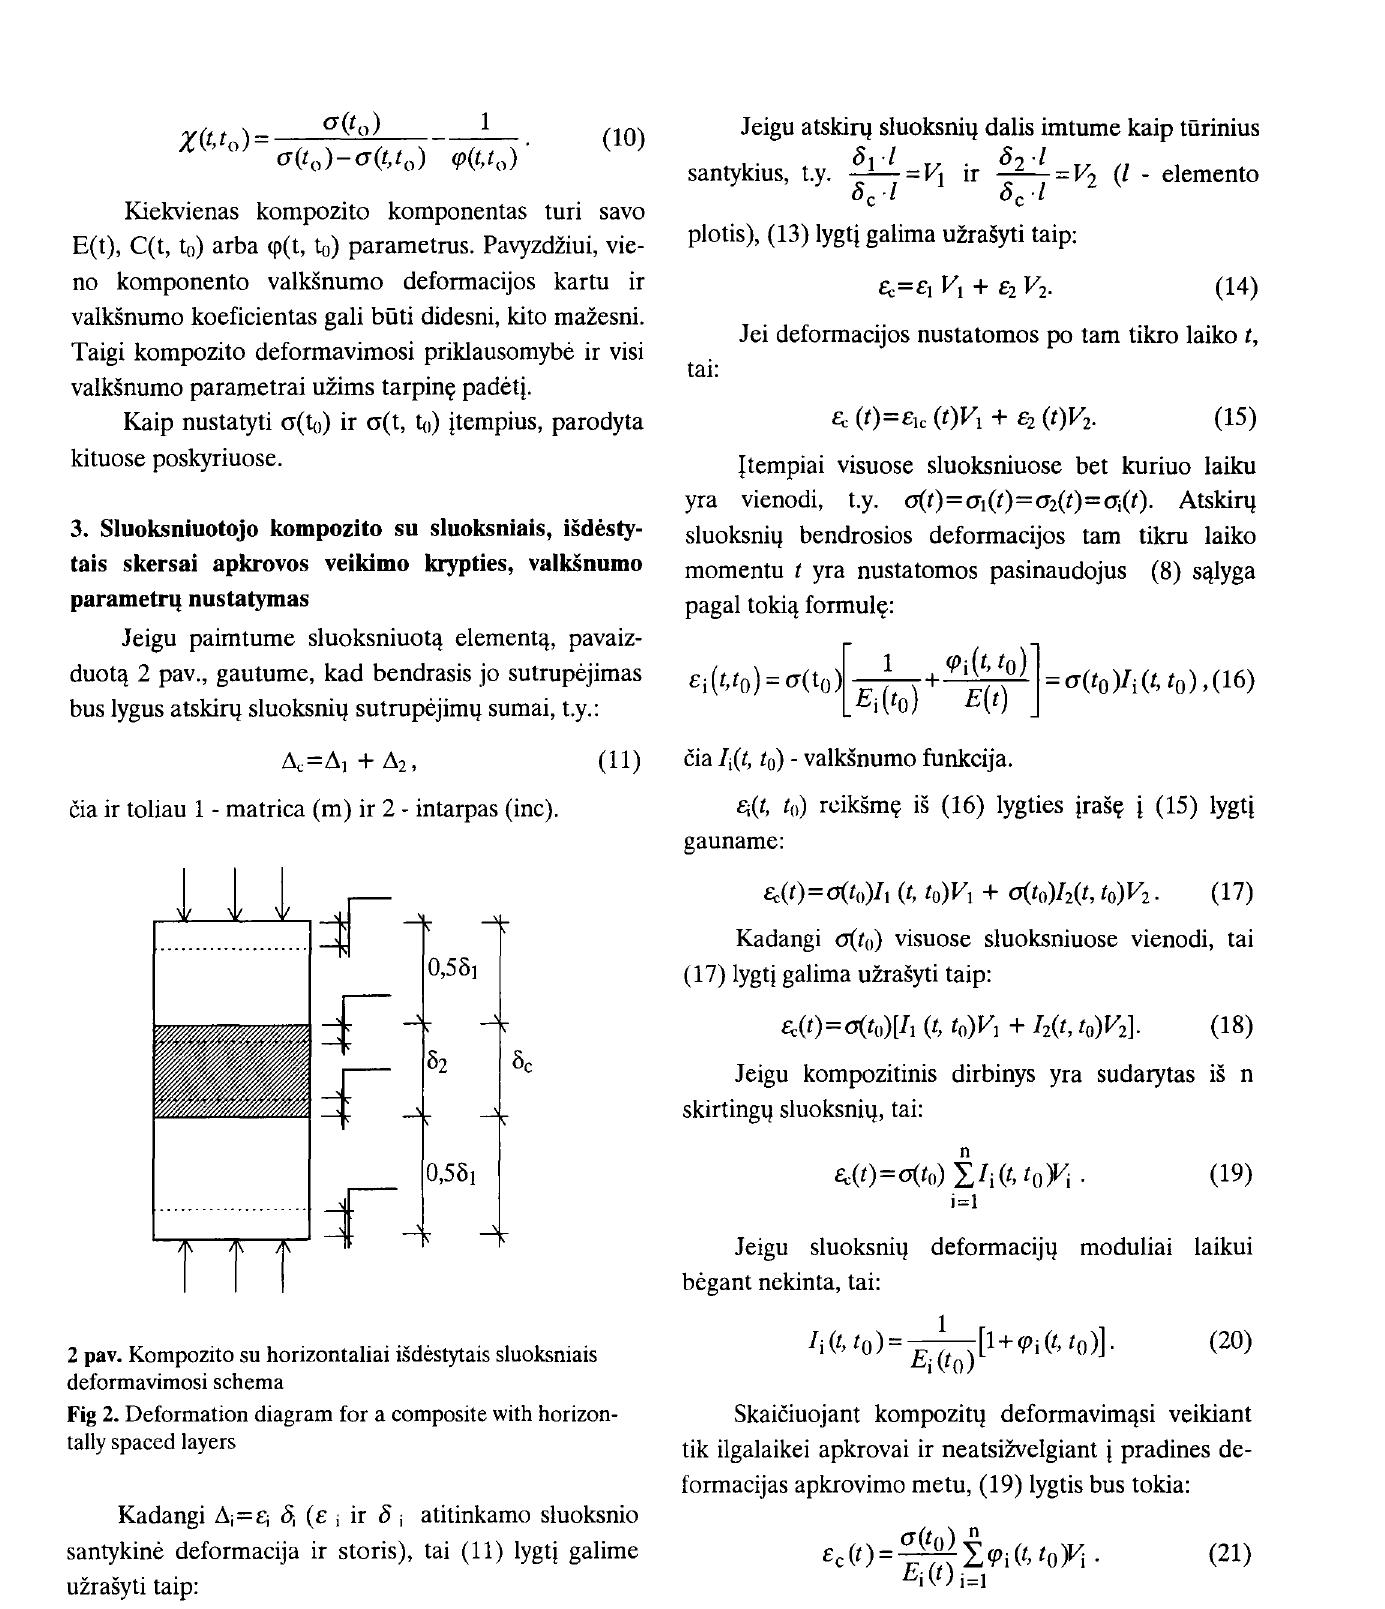
Fig 2. Deformation diagram for a composite with horizon tally spaced